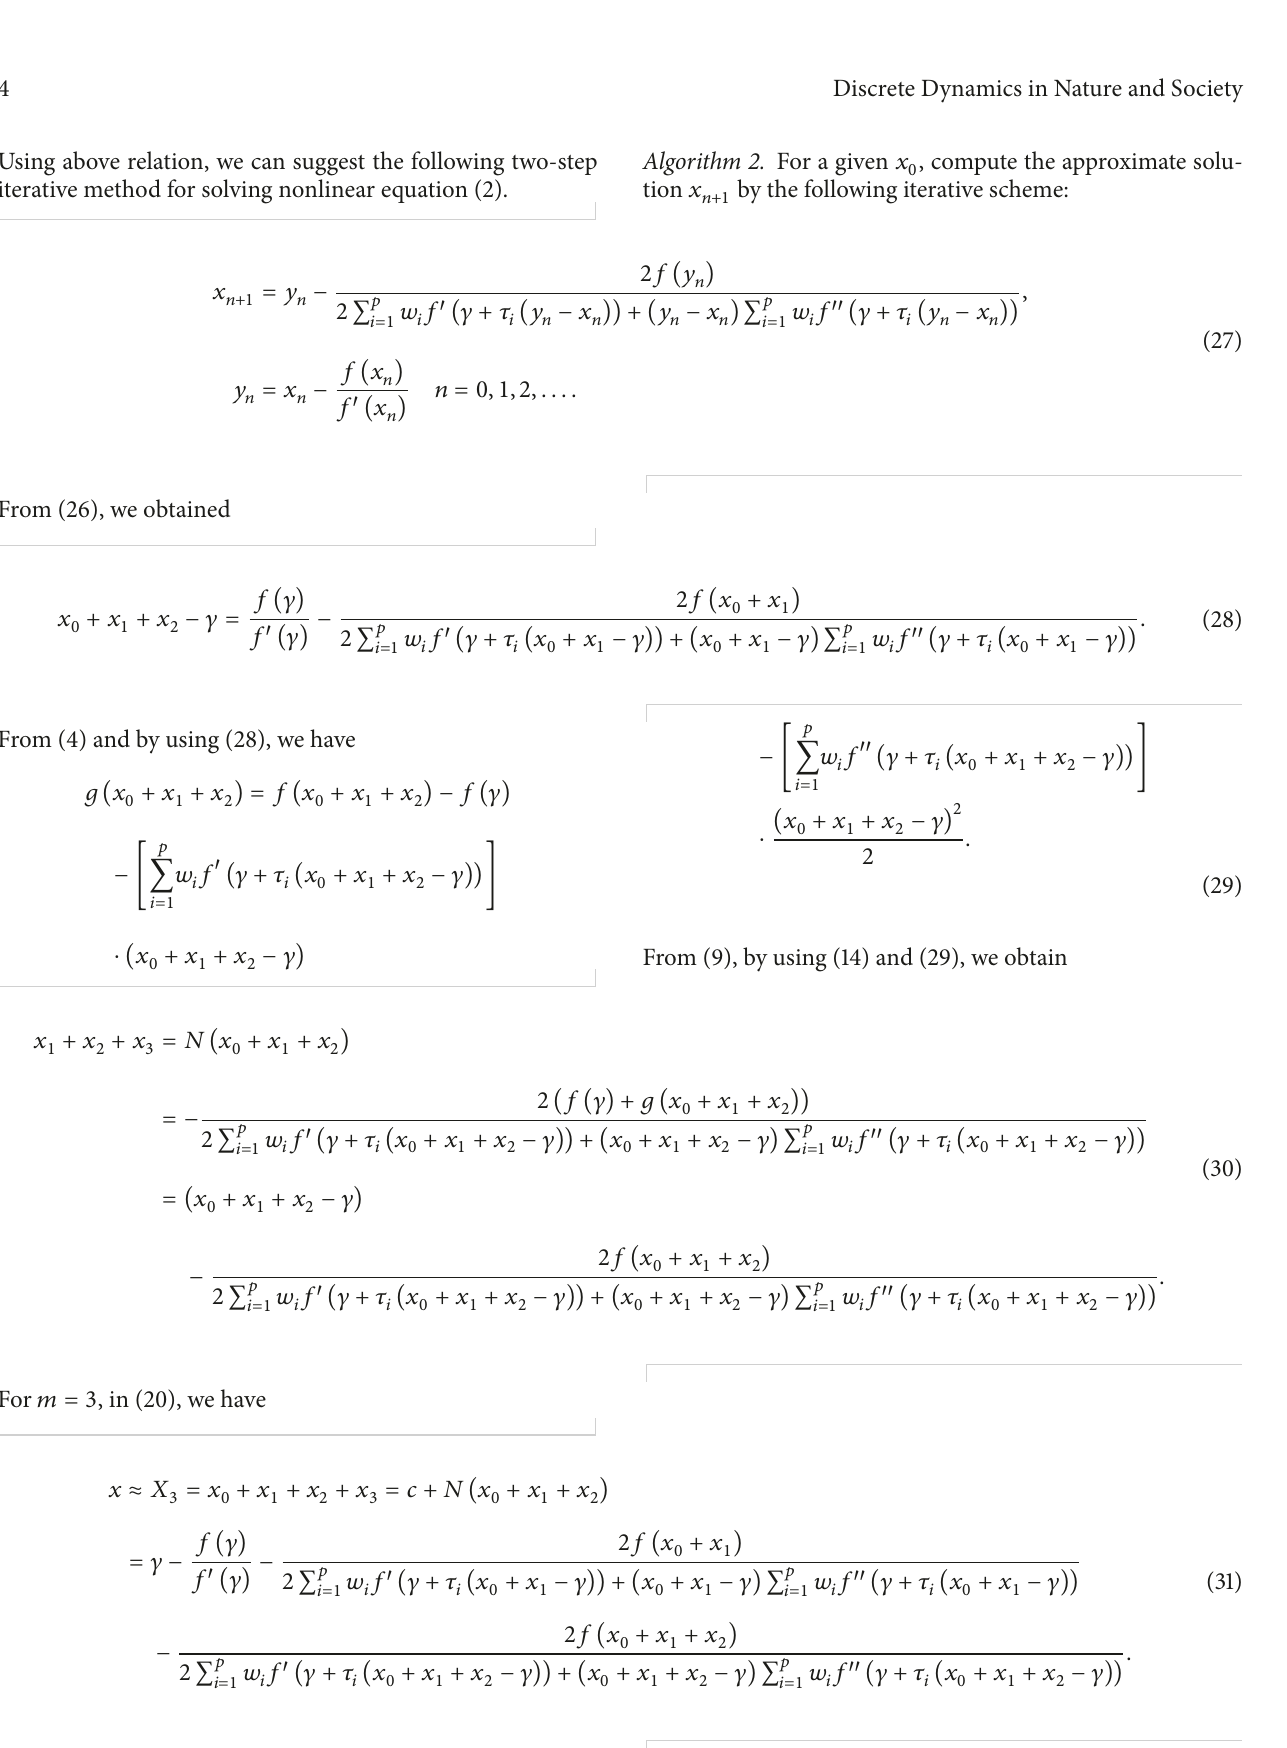
Algorithm 3. For a given 𝑥 0 , compute the approximate